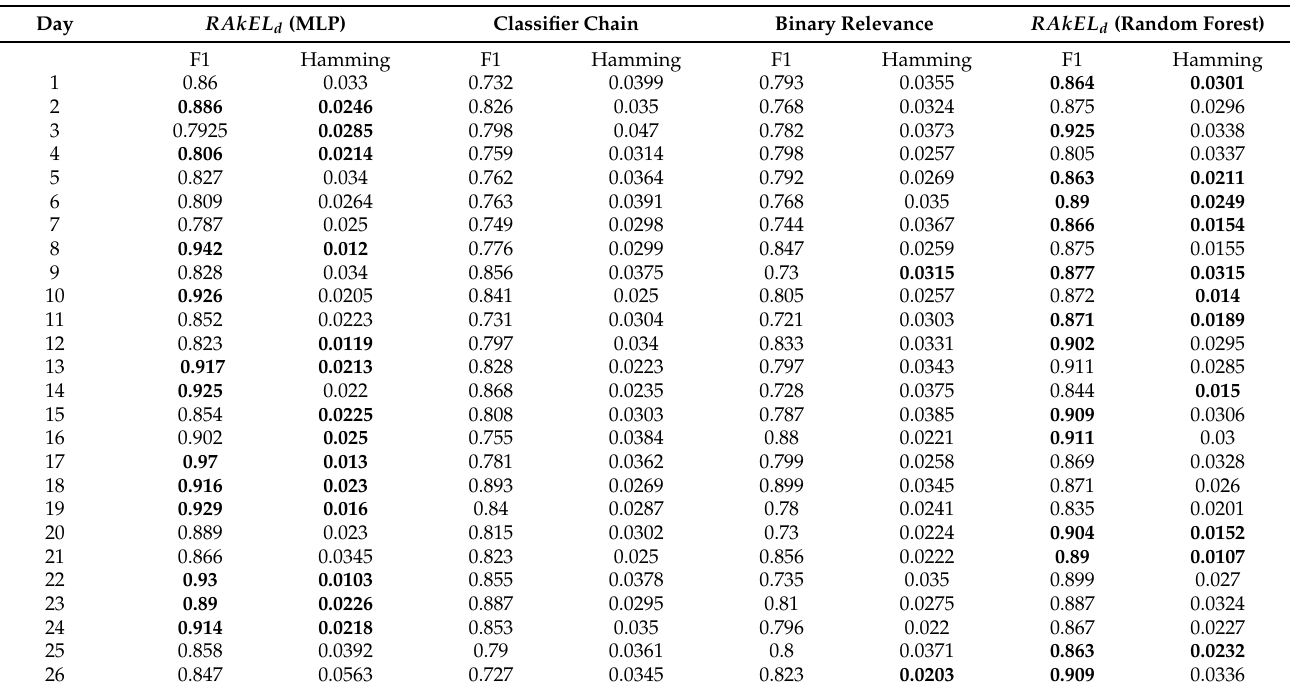
Table 12. Average F1 score and Hamming loss per day for the CASAS Dataset. Best values per day can be seen in